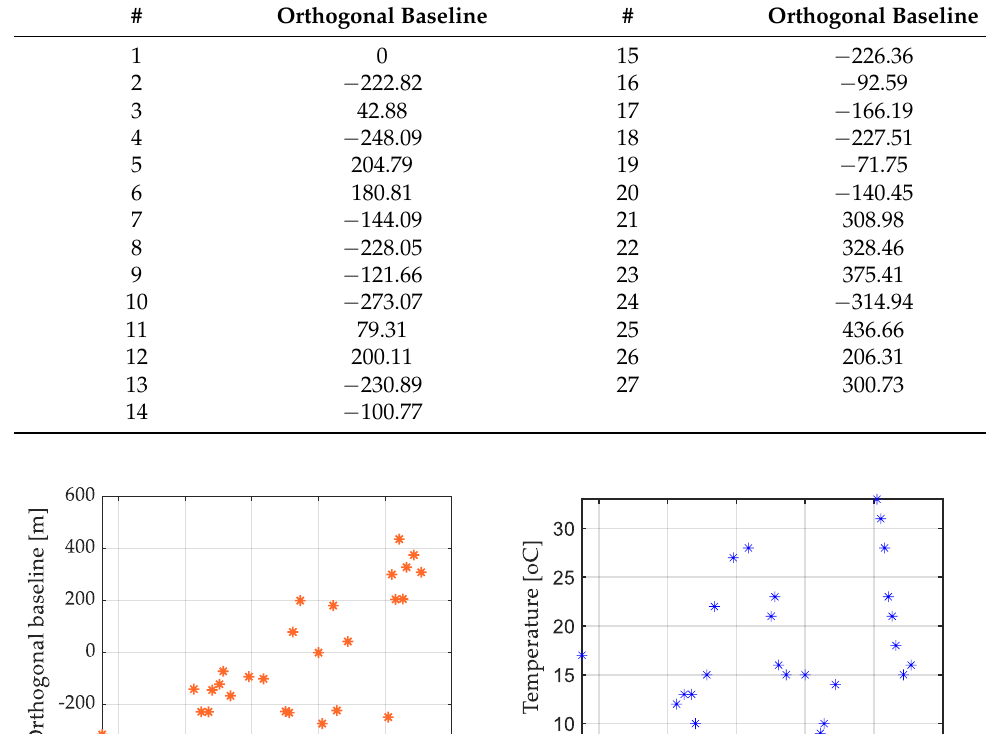
Table 3. TSX orthogonal baselines.